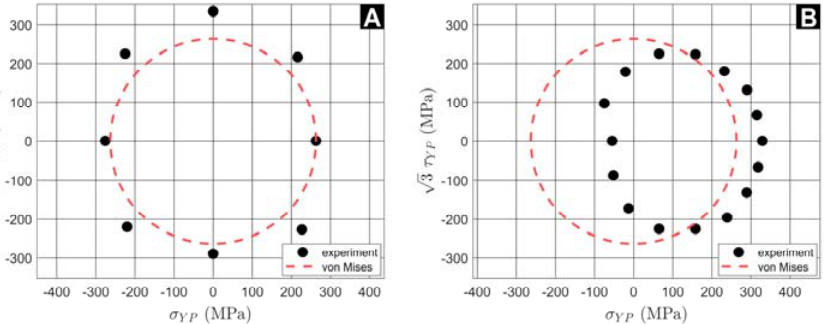
Figure 5. Initial YS of P250GH steel ( A ), and subsequent YS after 1% axial plastic prestrain ( B ).